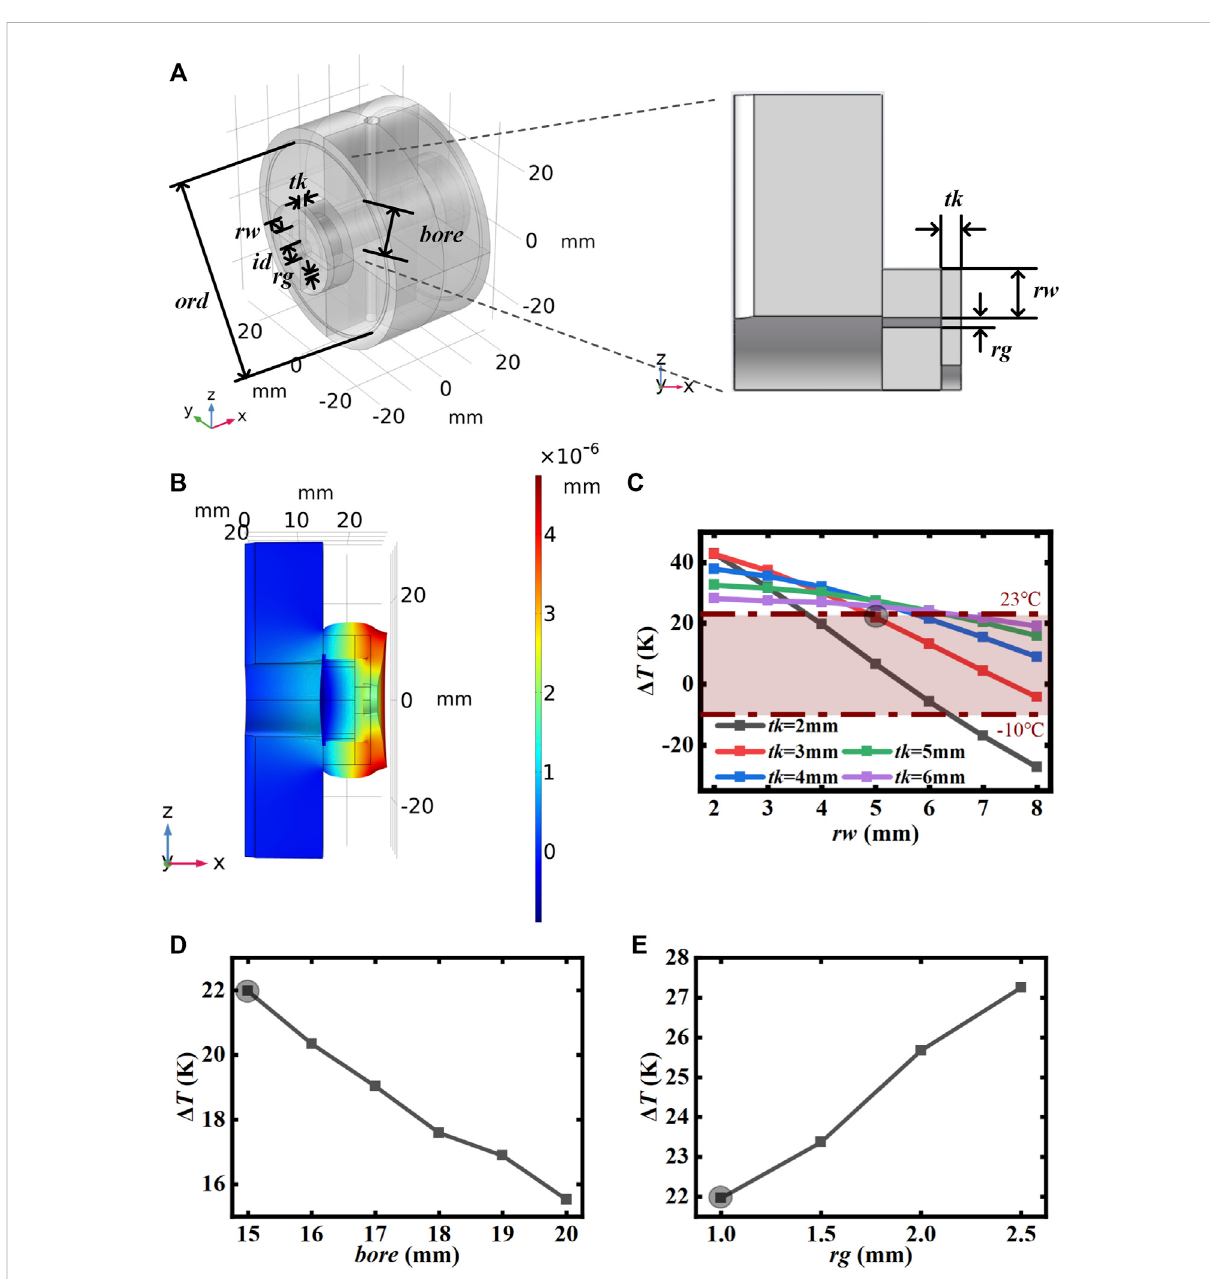
FIGURE 4 (A) 3Dmodelandofthecross-sectionofthe “ lanternring ” structurecavity. (B) FEAsimulationsofthe “ lantern ” structurecavitydeformationafter a 1-K temperature step. (C) Compensation temperature difference for bore-aperture of 15 mm and a side ring gap of 1 mm. (D) Compensation temperature difference for cover ring thickness of 3 mm, side ring width of 5 mm, and a side ring gap of 1 mm. (E) Compensation temperature difference for cover ring thickness of 3 mm, side ring width of 5 mm, and bore-aperture of 15 mm. The gray shadow in (C – E) shares the same structural parameters. od , ring outer diameter. ord , O-ring diameter; id , cover ring inner diameter; tk , cover ring thickness; bore , bore-aperture; rw , side ring width; rg , side ring